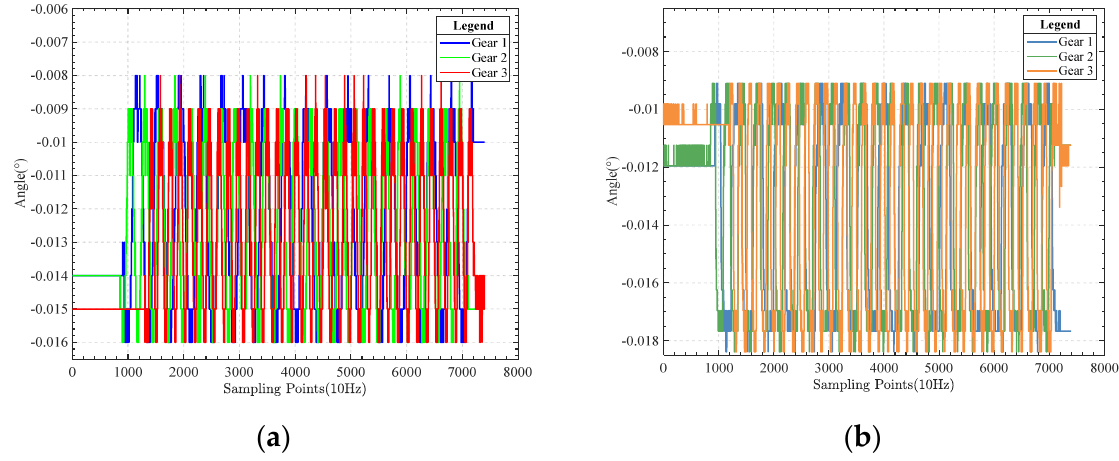
Figure 14. ( a ) Dynamic experimental pitch angle data; ( b ) dynamic experimental roll angle data. The comparison chart shows that the control effect of the algorithm is the same